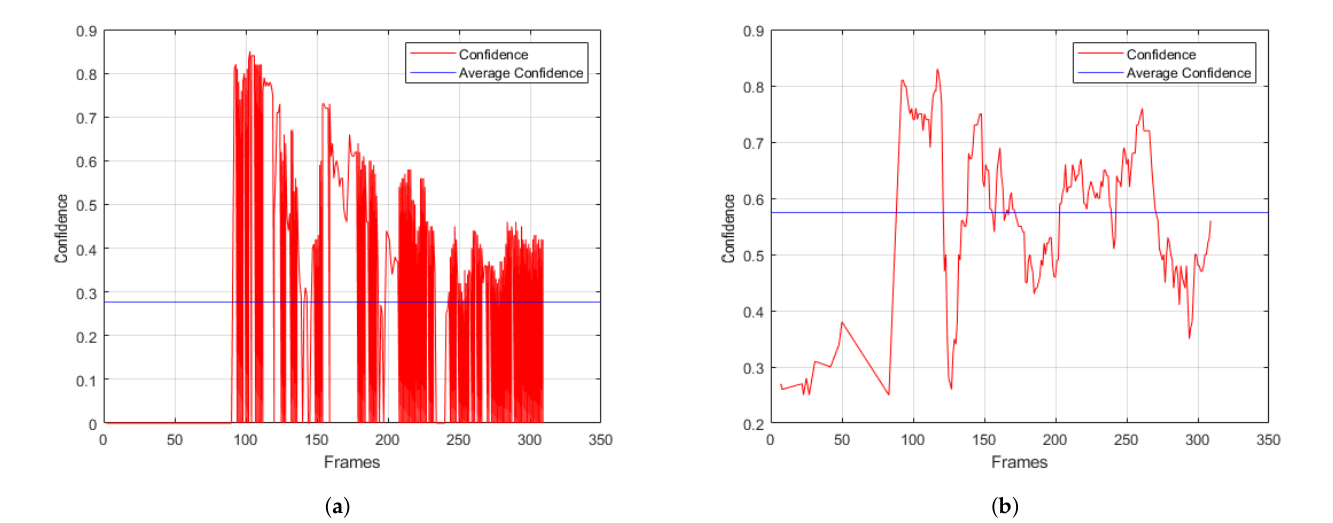
Figure 15. Stabilization graph of a forklift over 10 s: ( a ) small model; ( b ) xlarge model. Table 2. Stabilization results from forklift detection over 10 s with small and xlarge model.